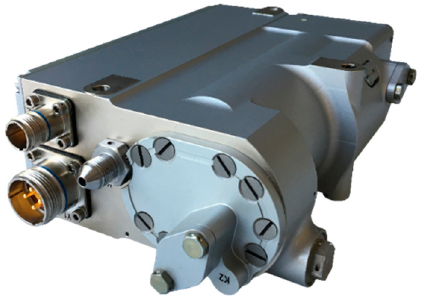
Figure 12. JSC FED Electrically driven fuel metering unit (PMSM electric motor + gear pump) with built-in control electronic (serial production).